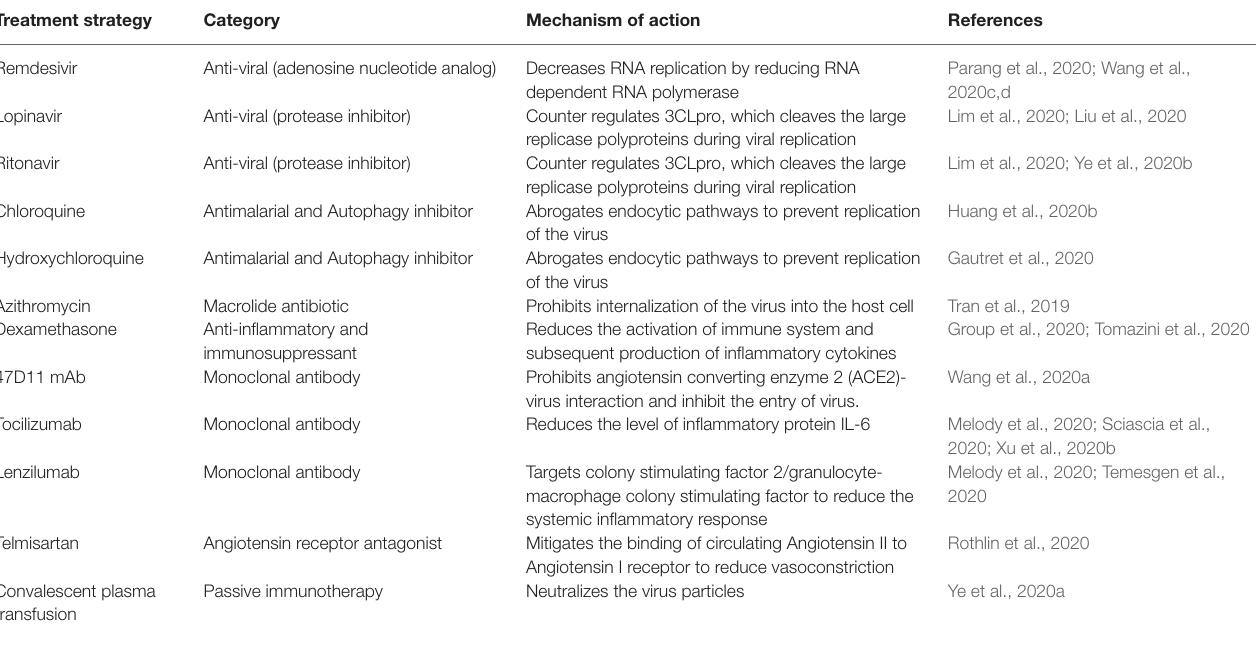
TABLE 2 | Potential treatment strategies used against SARS-CoV-2